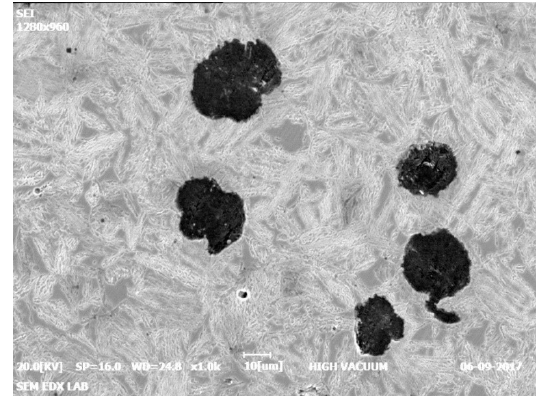
Figure 4. SEM image for ADI sample austenitized at 850ºC and austempered at 320ºC with 1.01 wt% Mn.